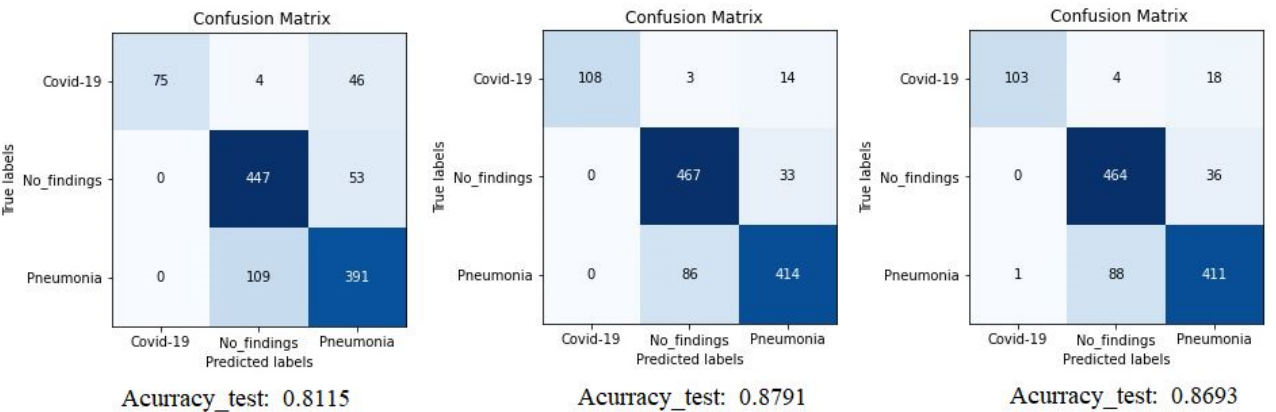
Figure 5. Confusion matrix for Densenet-161 trained with X-ray images. The first matrix is relative to the SGD optimizer, the second is to the ADAM optimizer and the third is to the RMSprop optimizer. (testing phase).